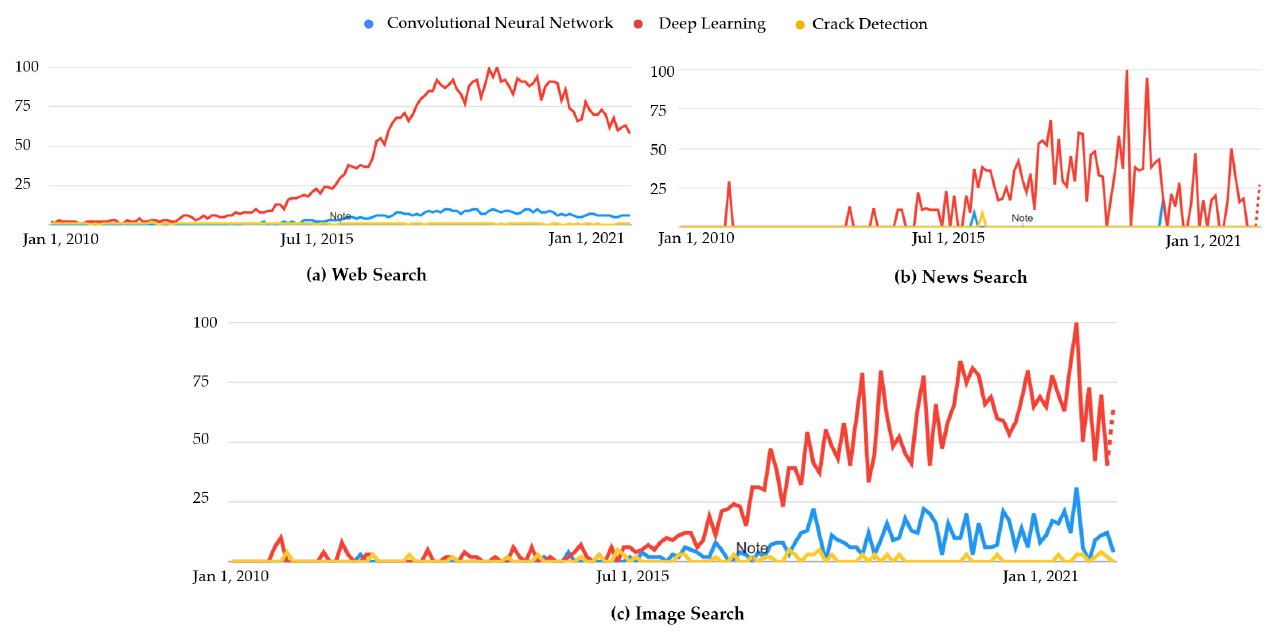
Figure 3. Google trend analysis of the proposed work keywords. ( a ) Web Search, ( b ) News Search, ( c ) Image Search.